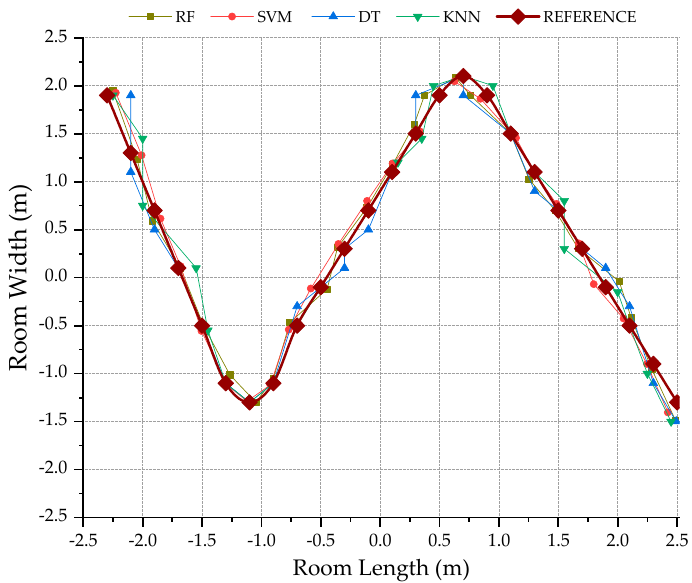
Figure 25. Estimated route after noise reduction and area division.